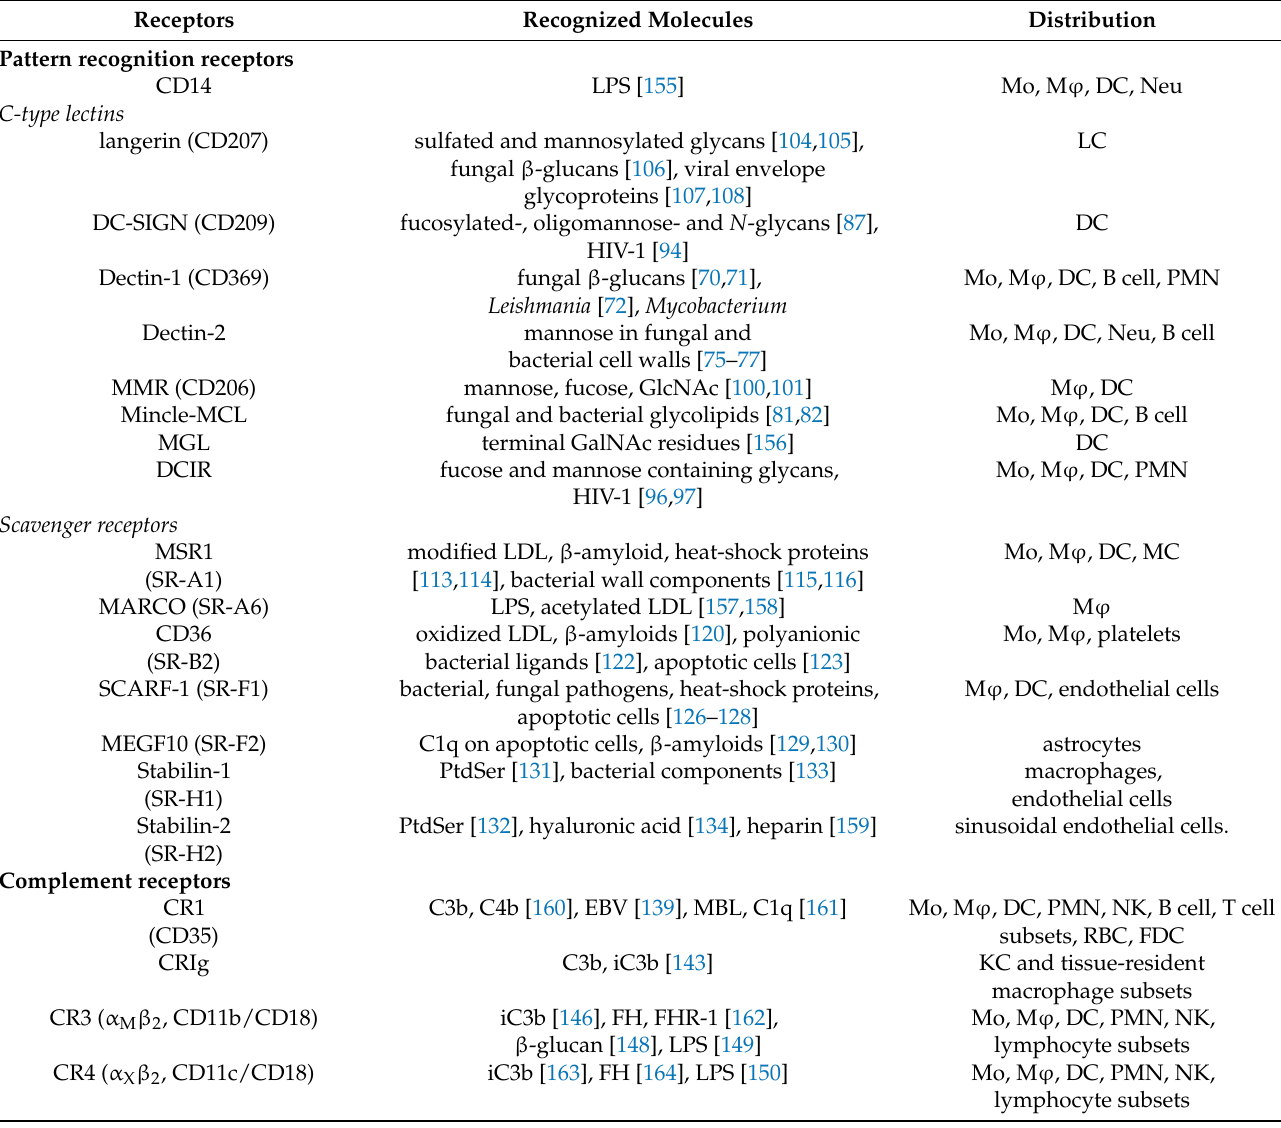
Table 1. Phagocytic receptors in